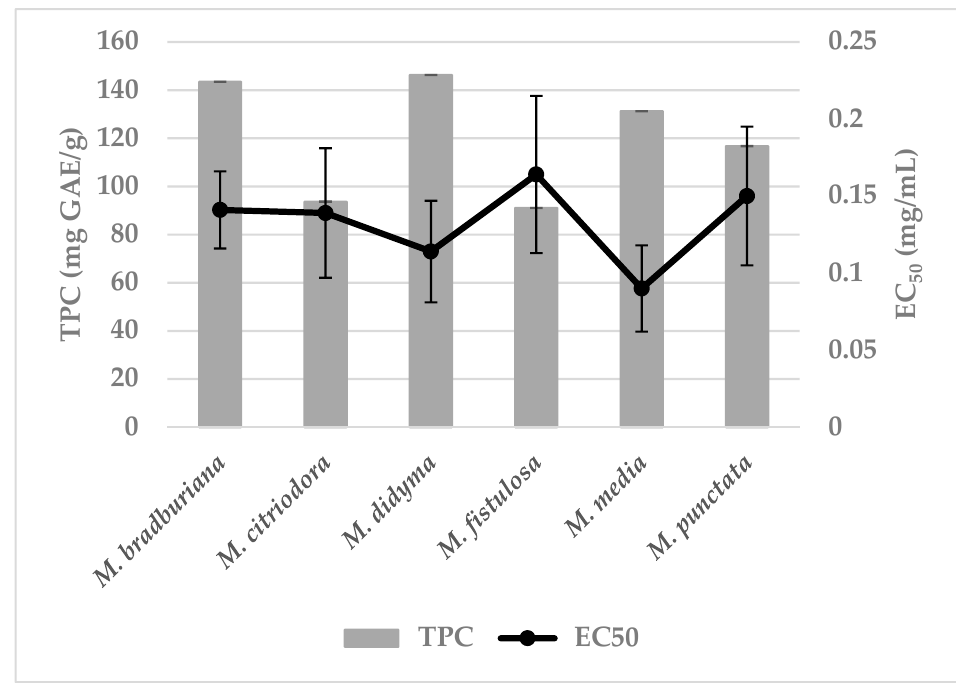
Figure 3. The total polyphenol content (TPC) calculated as gallic acid equivalents (GAE) in 70% ( v/v ) methanolic extracts of Monarda species, together with their antioxidant activity (EC 50 value). Mean values ± SD were presented ( n = 3).